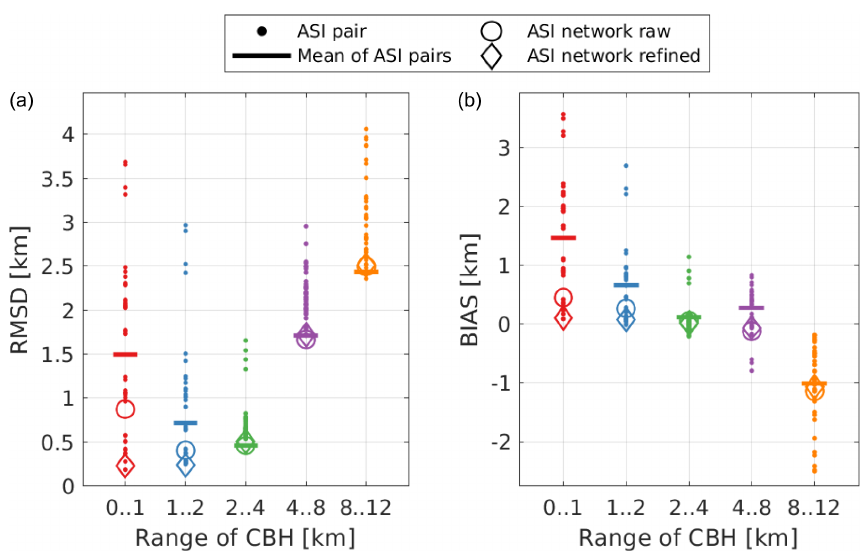
Figure 10. RMSD (a) and bias (b) for five ranges of the CBH received for all individual ASI pairs (dots), for the ASI network without (circles) and with refinements (diamonds) and for a basic average of the CBH measured by all ASI pairs (horizontal